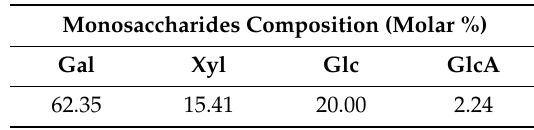
Table 2. Monosaccharides composition of